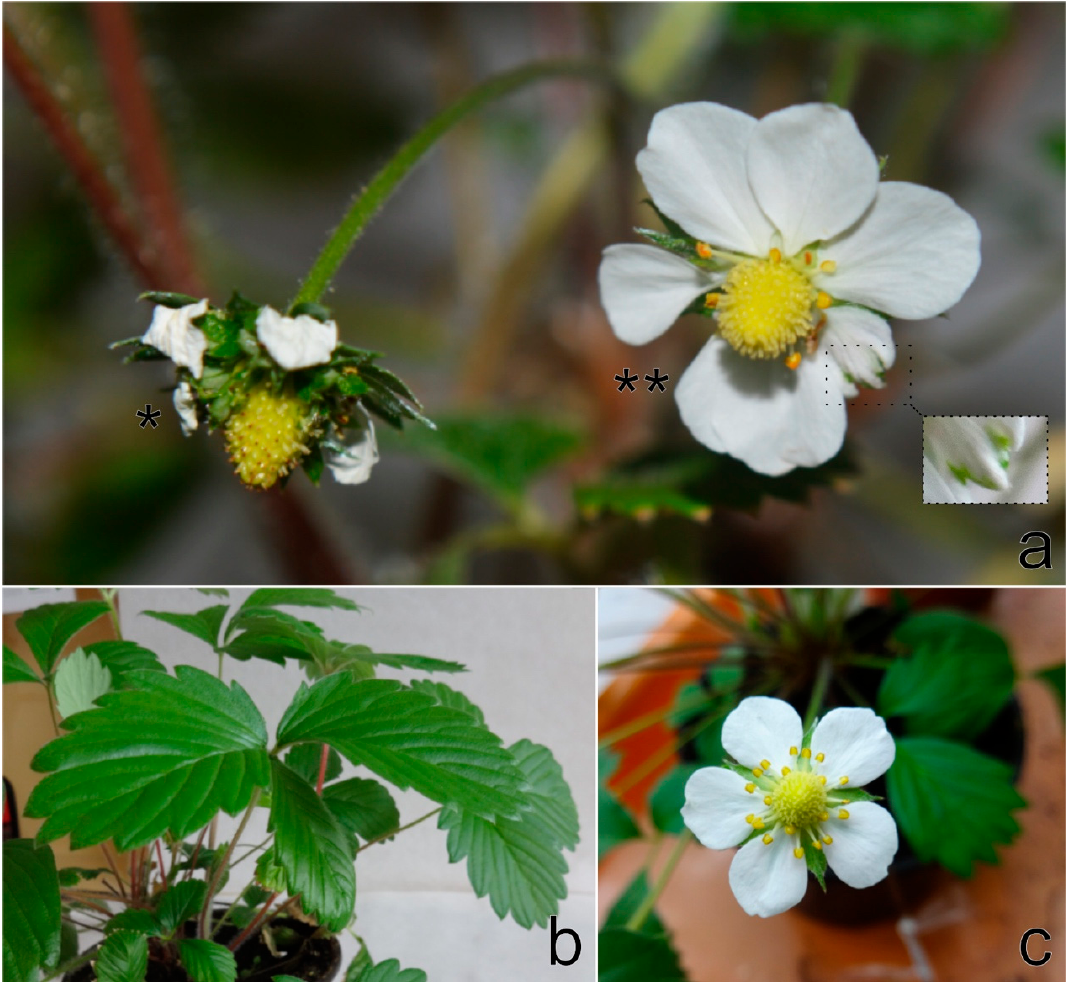
Figure 12. F. vesca semperflorens ‘Alpine’ inoculated by grafting with StrV-1-24 / 2016(A, B, C), exhibiting ( a ) multiplication of calyx leaves on one flower (*), petal deformation together with light-green streaks and an irregular length and number of flower structures on the second flower (**), and ( b ) leaf epinasty 84 days after grafting; ( c ) A flower from the healthy control.